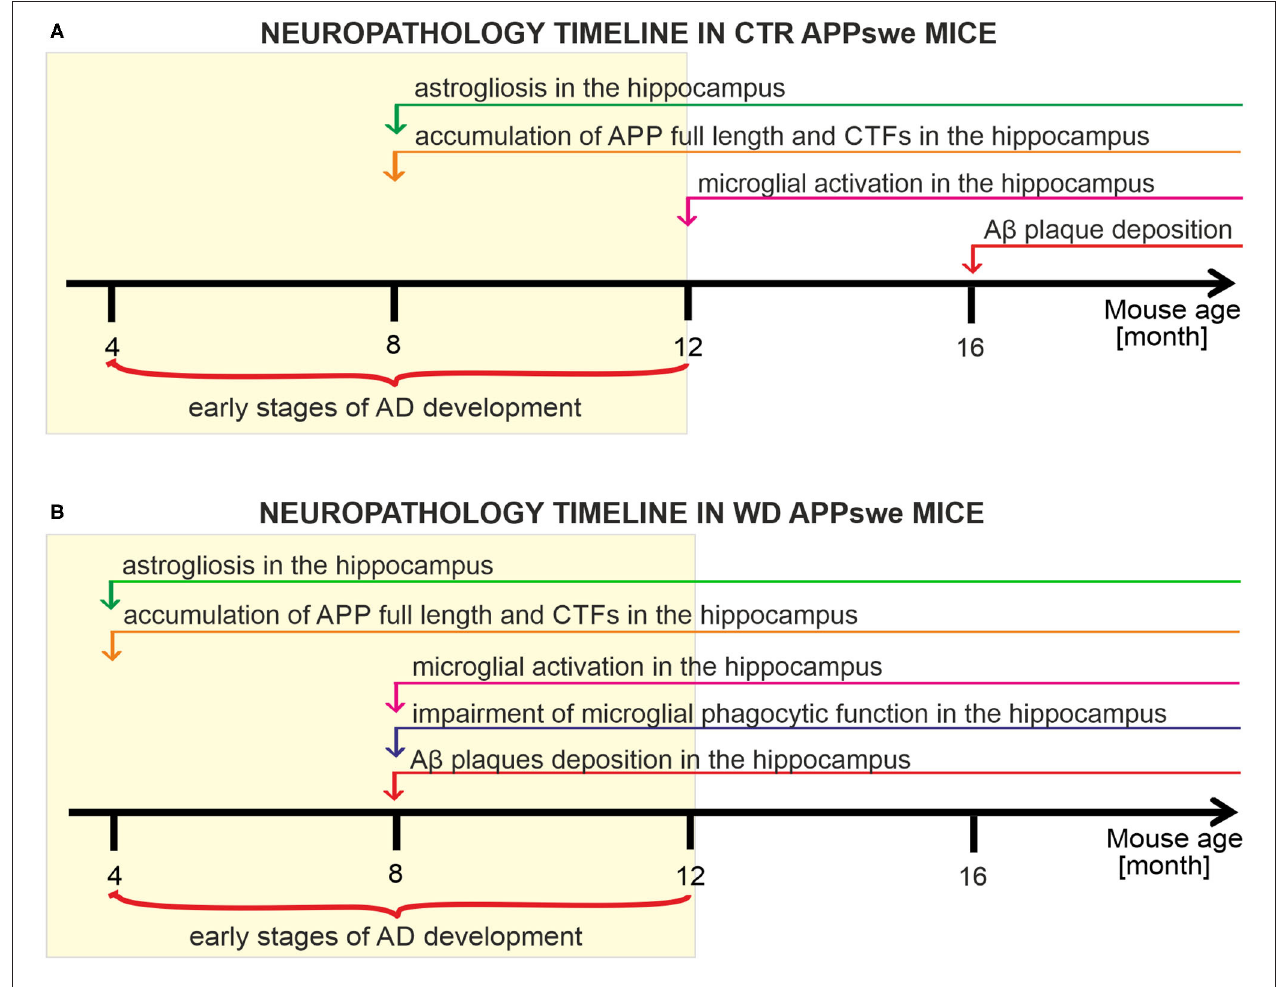
FIGURE 8 | Timelines presenting the neuropathology cascades of events in APPswe mice fed with standard diet compared to mice fed western diet. (A) Timeline showing the neuropathological cascades of events in the brain of control APPswe mice fed with standard chow diet. (B) Timeline of the WD-induced neuropathological cascades of events in APPswe mouse brain shows the accelerated pathology induced by Western diet feeding.